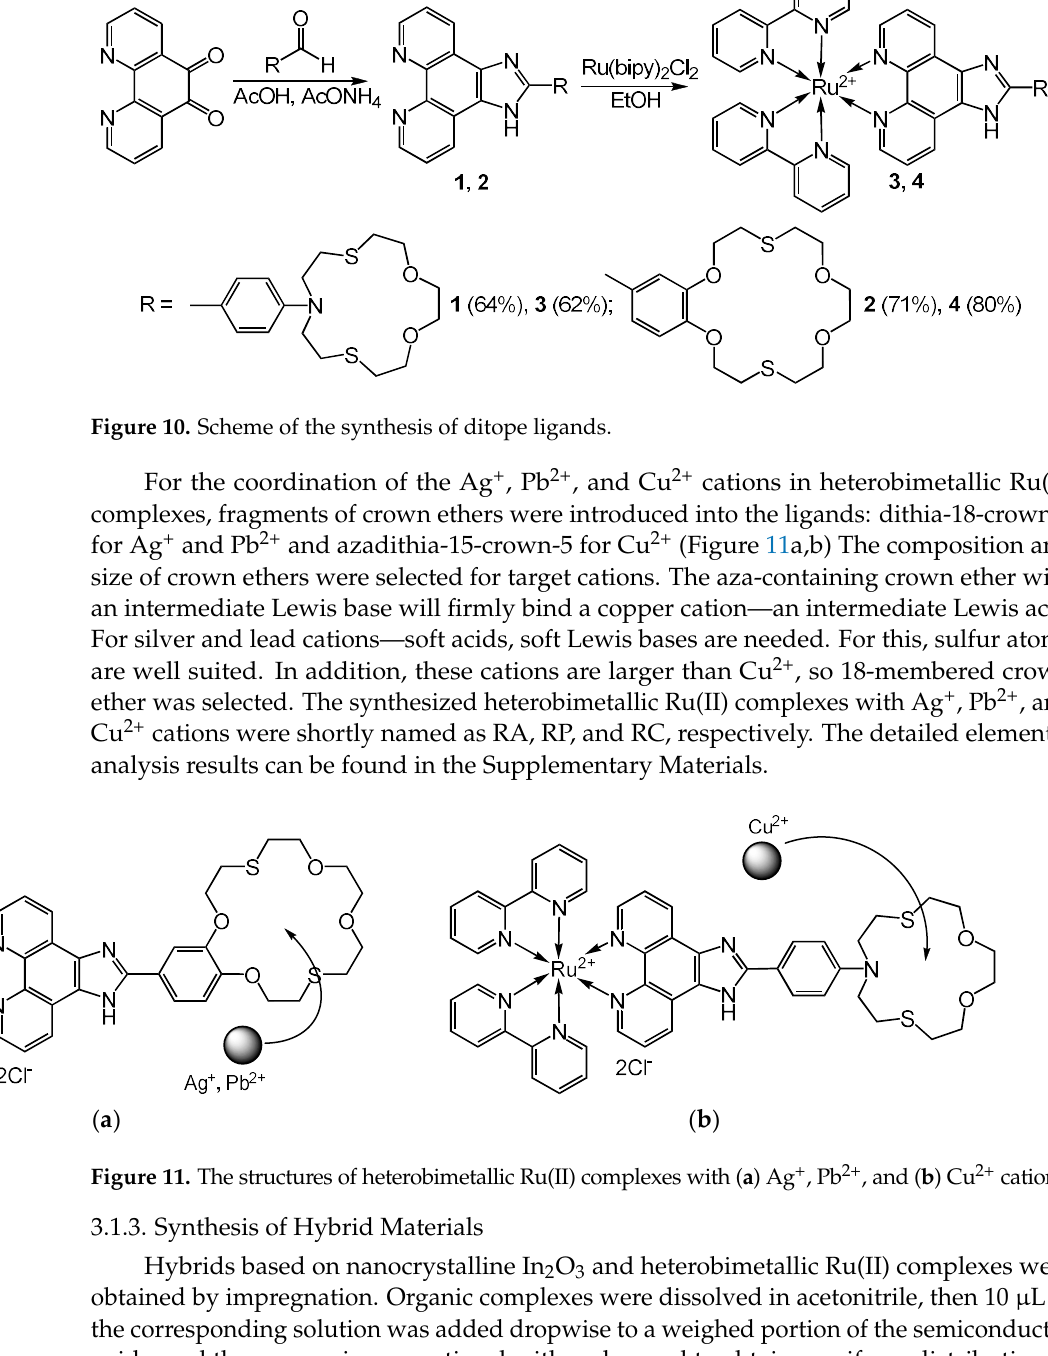
Figure 11. The structures of heterobimetallic Ru(II) complexes with ( a ) Ag + , Pb 2+ , and ( b ) Cu 2+ cat- ions.